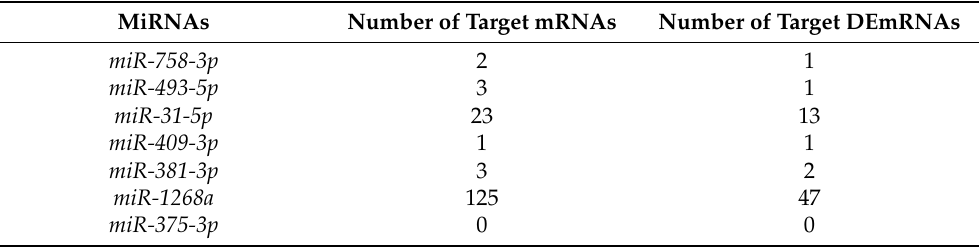
shown in the networks. Red, green, and blue dots represent significantly upregulated miRNAs, significantly downregulated miRNAs, and targeted mRNAs, respectively. The pink and green lines represent positive and negative correlations, respectively. ( c ) Top 30 GO terms in the GO enrichment analysis of targeted DEmRNAs. Green, orange, and purple represent BP, CC, and MF, respectively. MicroRNA, miRNA; differentially expressed, DE; biological process, BP; cellular component, CC; molecular function, MF. Table 3. The number of mRNAs targeted by miRNAs. MiRNAs Number of Target